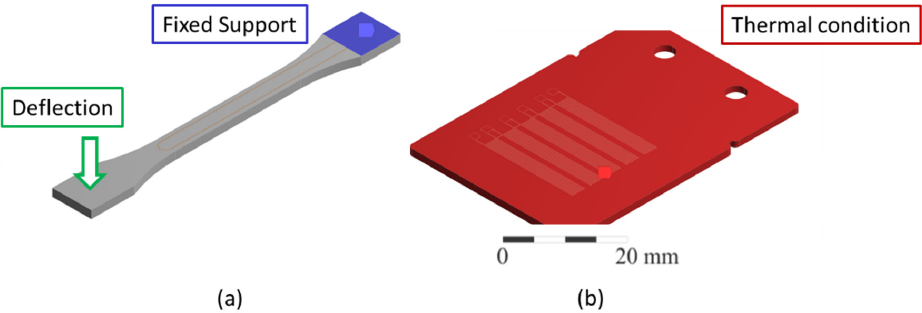
Table 2. Materials’ data, on which the simulations are based [20].